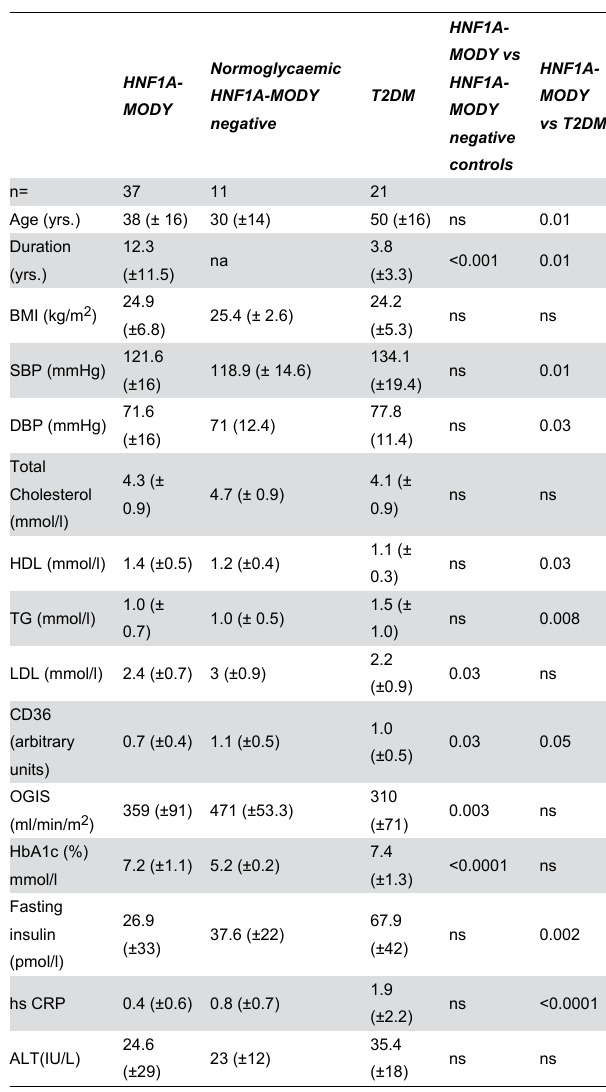
Table 1. Clinical characteristics of